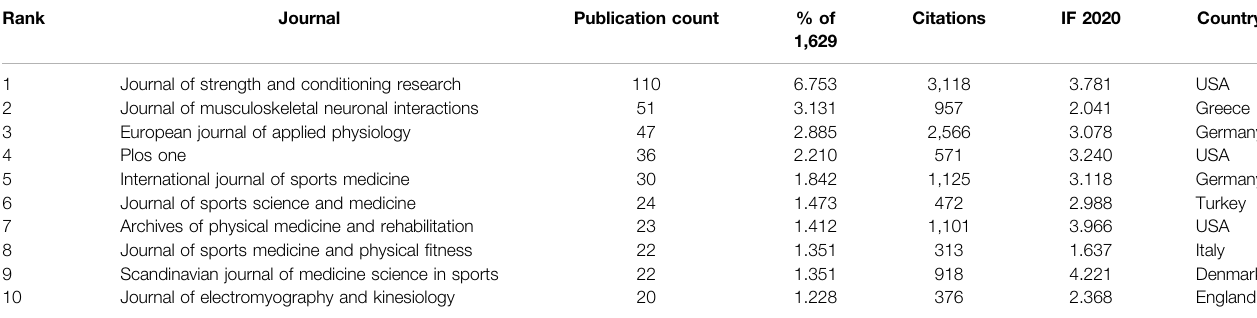
TABLE 5 | Top 10 productive journals in the WBVT study.